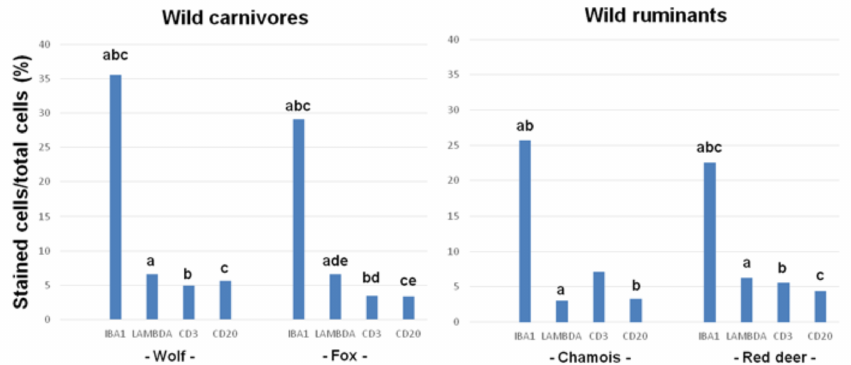
Figure 1. Intra-species di ff erences in the numbers of macrophages (based on Iba1 immunostaining), plasma cells (lambda chain), T lymphocytes (CD3) and B lymphocytes (CD20) in skin mange lesions from wild carnivores and ruminants. For each animal species, the same letters above di ff erent rectangular bars indicates significant di ff erences between means. For wolf: (a, b, c) p < 0.001. For fox: (a, b, c, d, e) p < 0.05. For chamois: (a, b) p < 0.05. For red deer: (a, b, c) p < 0.001. A Tukey test for multiple comparisons was applied for statistical